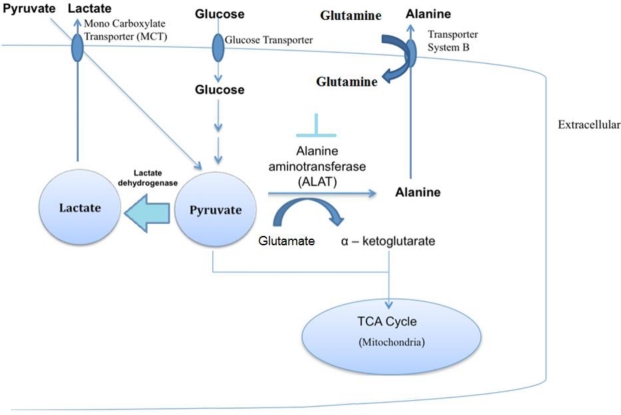
Schematic of alanine metabolism in Caco-2 cells. Here it is shown that Caco-2 cells absorb glucose, glutamine, and pyruvate from the medium and produce lactate and alanine that are released. Over time, glucose, glutamine, and pyruvate concentrations decrease in the medium while lactate and alanine concentrations increase.